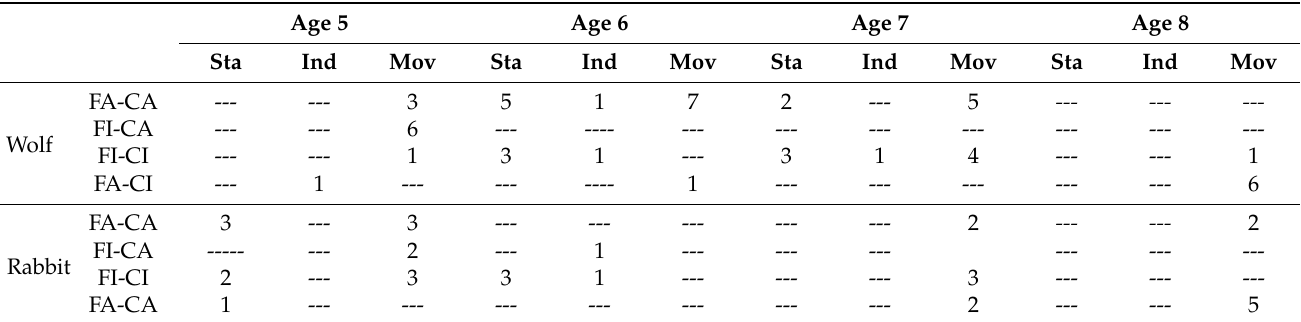
Table 2. Most significant vectors of the macrocategories in each age for the two characters according to the